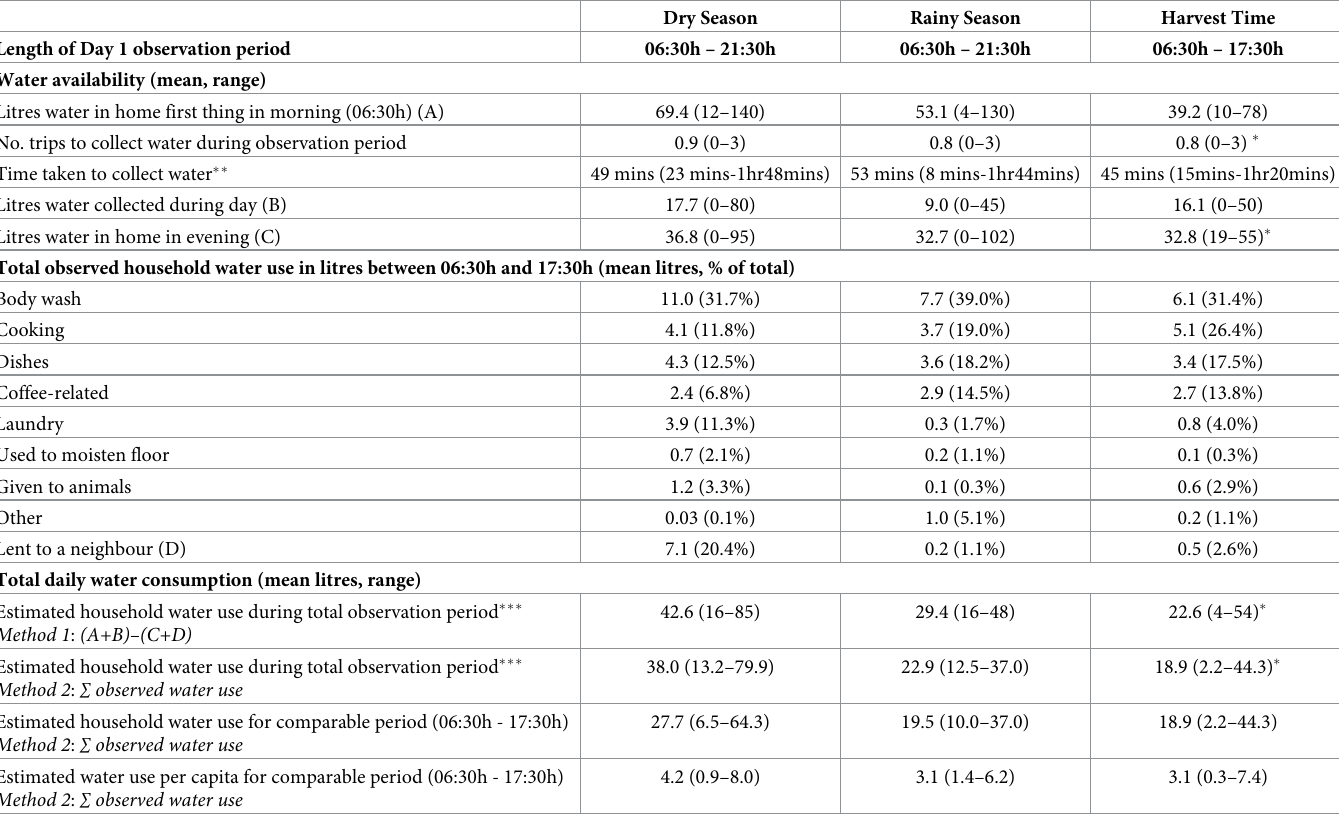
Table 2. Seasonal variation in household water availability and use during the Day 1 Observation